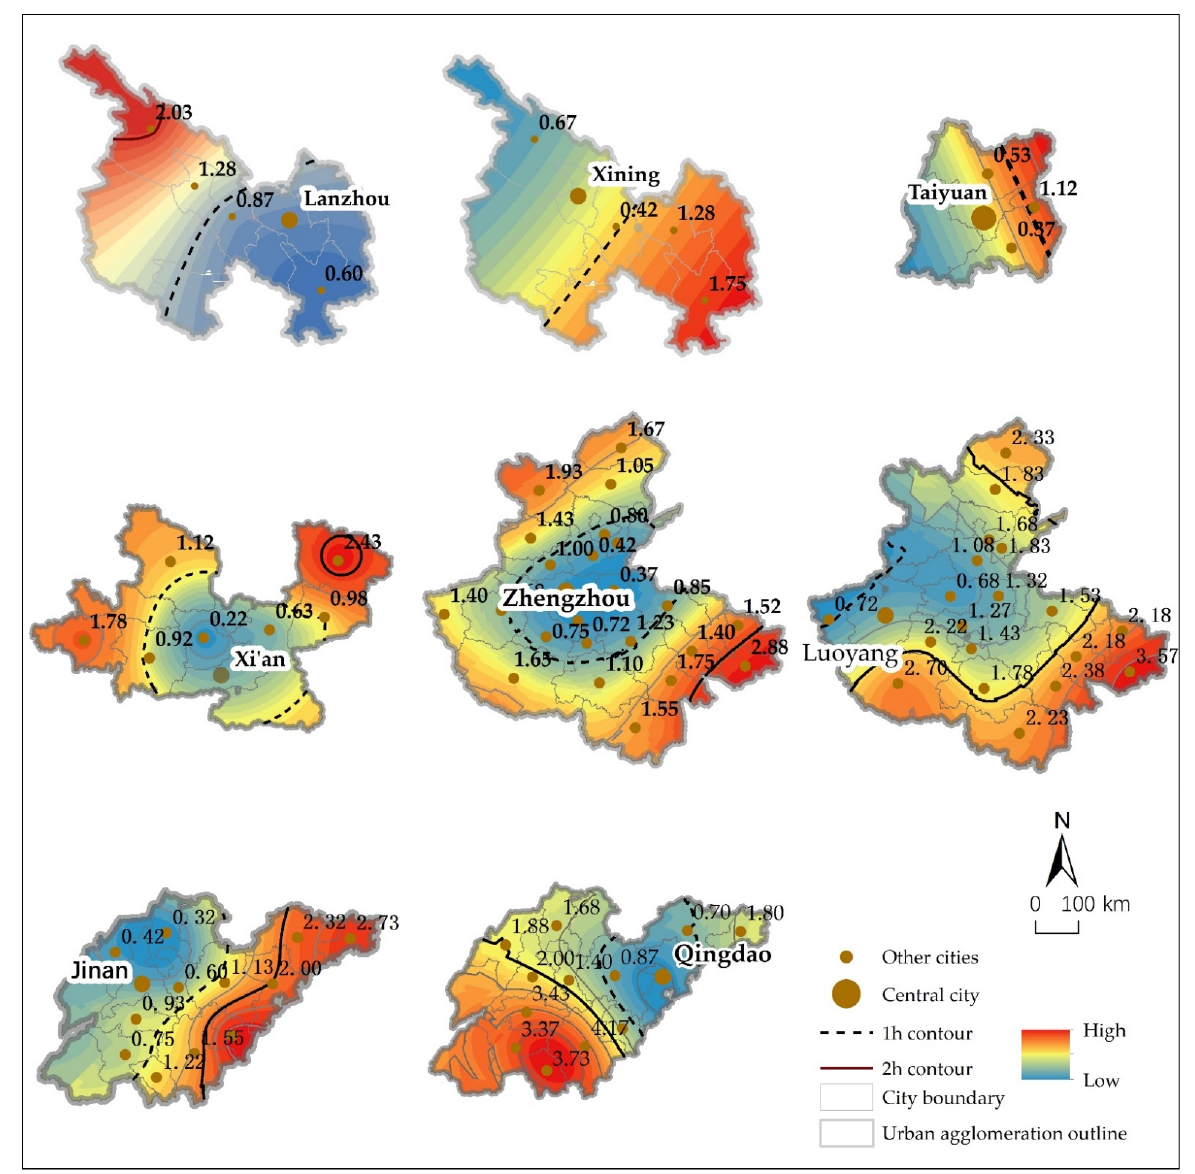
Figure 5. The pattern of access to the central cities.